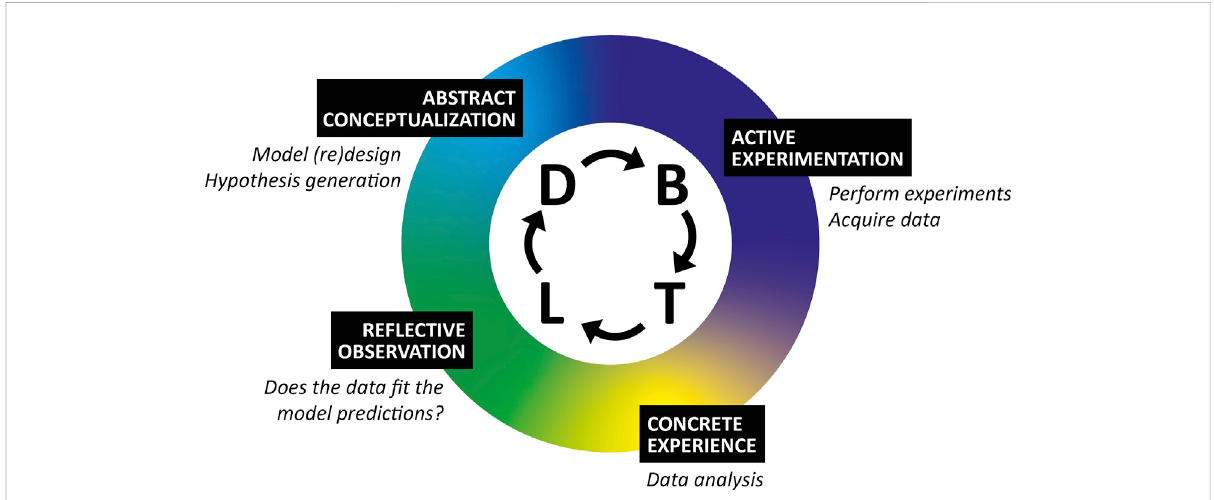
FIGURE 1 Comparison of DBTL and Kolbs ’ Learning Cycle. Kolb ’ s learning cycle (Kolbs, 1984) can be superimposed on the DBTL cycle to show how students complete both processes in tandem. In this schematic, the design phase of the DBTL cycle is linked with abstract conceptualisation of the biological problem and hypothesis generation, active experimentation and concrete experiences are obtained during the build and test phases wheredataisacquiredandanalysed,whilstlearningfromnewdatarequiresre fl ectiveobservationsandwhetherthedatamatchesthepredicted